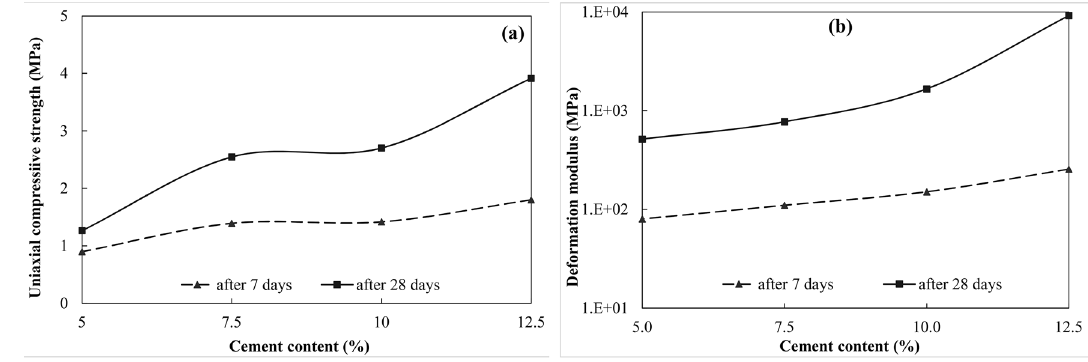
Fig. 9 The graph of uniaxial compressive strength (UCS) ( a ) and deformation modulus ( b ) versus cement content for CSG mixtures at two curing